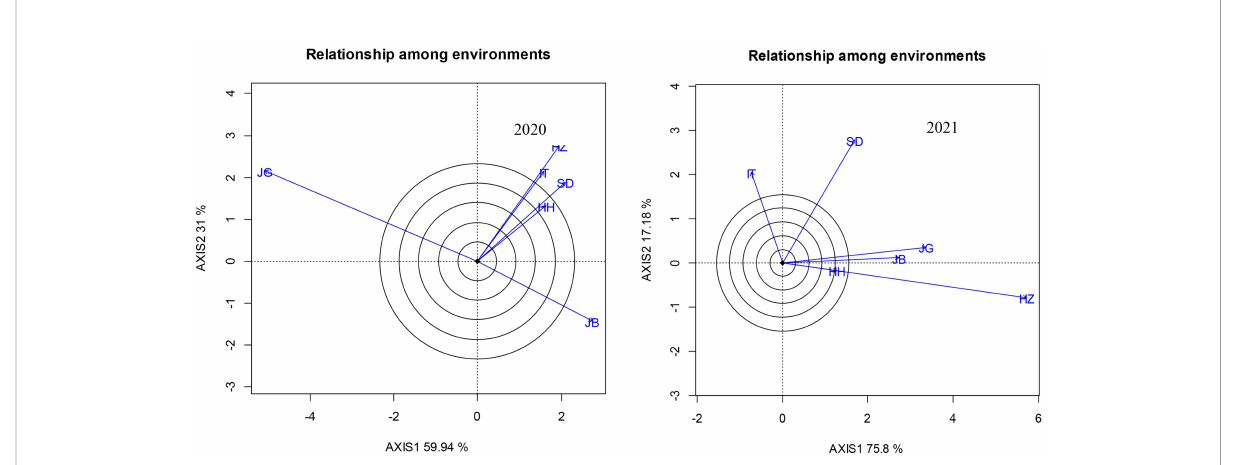
FIGURE 3 Relationship among locations under different sowing dates revealed by RDA analysis.